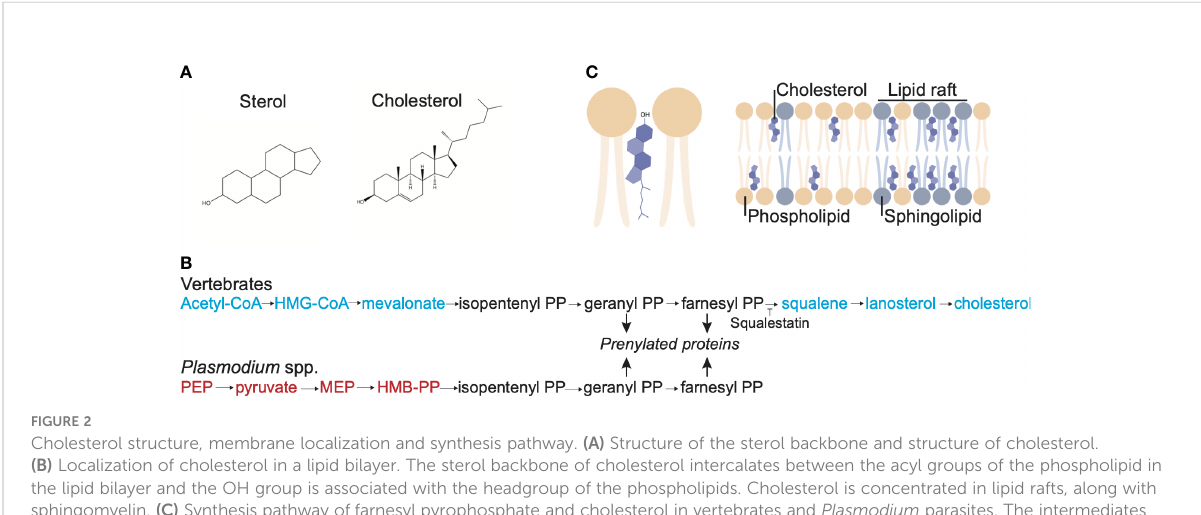
FIGURE 2 Cholesterol structure, membrane localization and synthesis pathway. (A) Structure of the sterol backbone and structure of cholesterol. (B) Localization of cholesterol in a lipid bilayer. The sterol backbone of cholesterol intercalates between the acyl groups of the phospholipid in the lipid bilayer and the OH group is associated with the headgroup of the phospholipids. Cholesterol is concentrated in lipid rafts, along with sphingomyelin. (C) Synthesis pathway of farnesyl pyrophosphate and cholesterol in vertebrates and Plasmodium parasites. The intermediates used in vertebrates but not Plasmodium parasites to produce farnesyl pyrophosphate are shown in blue, whereas the intermediates used in Plasmodium parasites but not in vertebrates are shown in red; in black are the shared intermediates. Note that Plasmodium parasites lack the enzymes required to convert farnesyl PP to